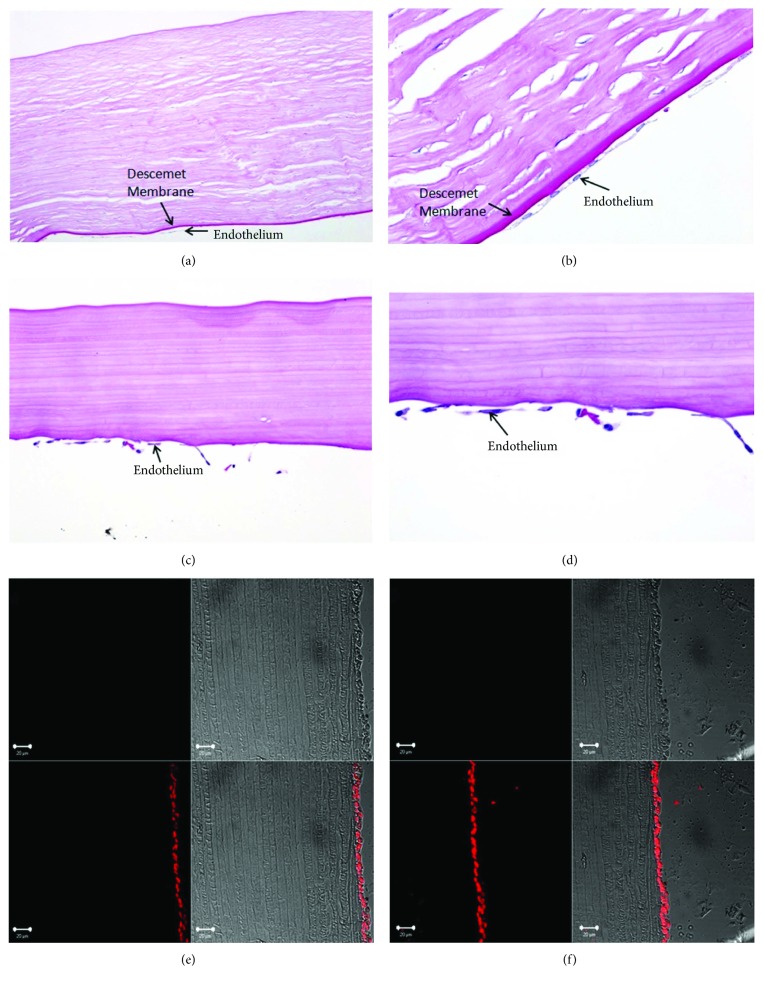
Histological analysis using periodic acid-Schiff staining. (a) A control human cornea showing the presence of Descemet's membrane and endothelial cells using PAS staining at 100x and (b) 400x. (c) FSS showing monolayer of endothelial cells at 200x magnification and (d) at 400x magnification. Histology did not show any clear evidence or development of Descemet's membrane on FSS by the HCEnCs but showed a monolayer of cells attached in most of the areas. (e) Collagen VI and (f) laminin as the extracellular markers did not express on the cells at day 11. Nucleus can be seen in red marked with Draq 5. FSS: fish scale scaffold; HCEnC: human corneal endothelial cell.